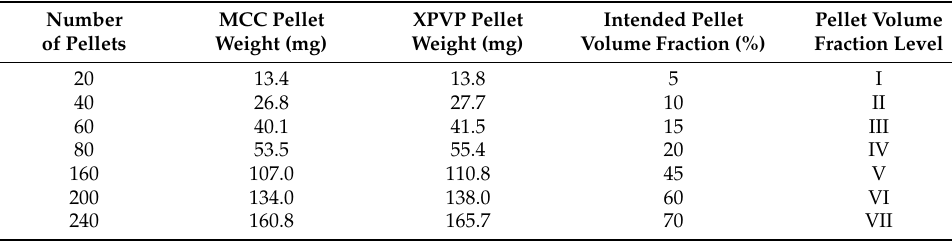
Table 2. MUPS tablet-preparation parameters to evaluate the pellet volume